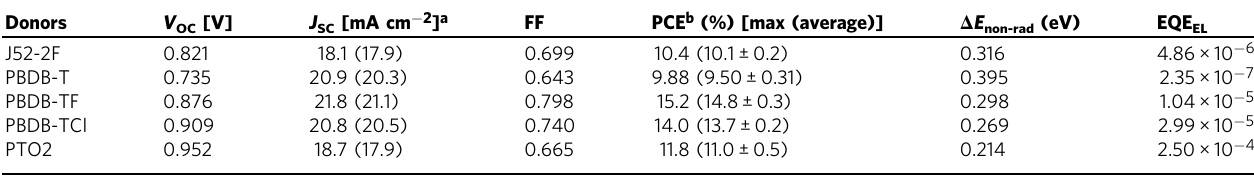
Table 2 Photovoltaic parameters of the polymers: A4T-16-based cells.